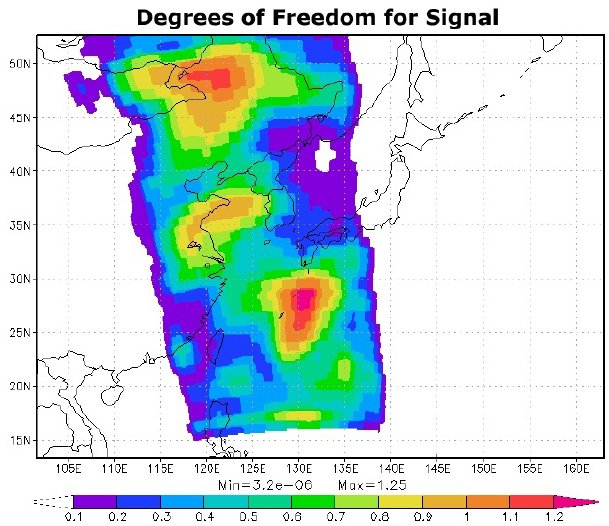
Figure 6. Degrees of freedom for signal (DFS) of assimilated total column O 3 observation valid at 06:00UTC, 3 September 2005. The units are